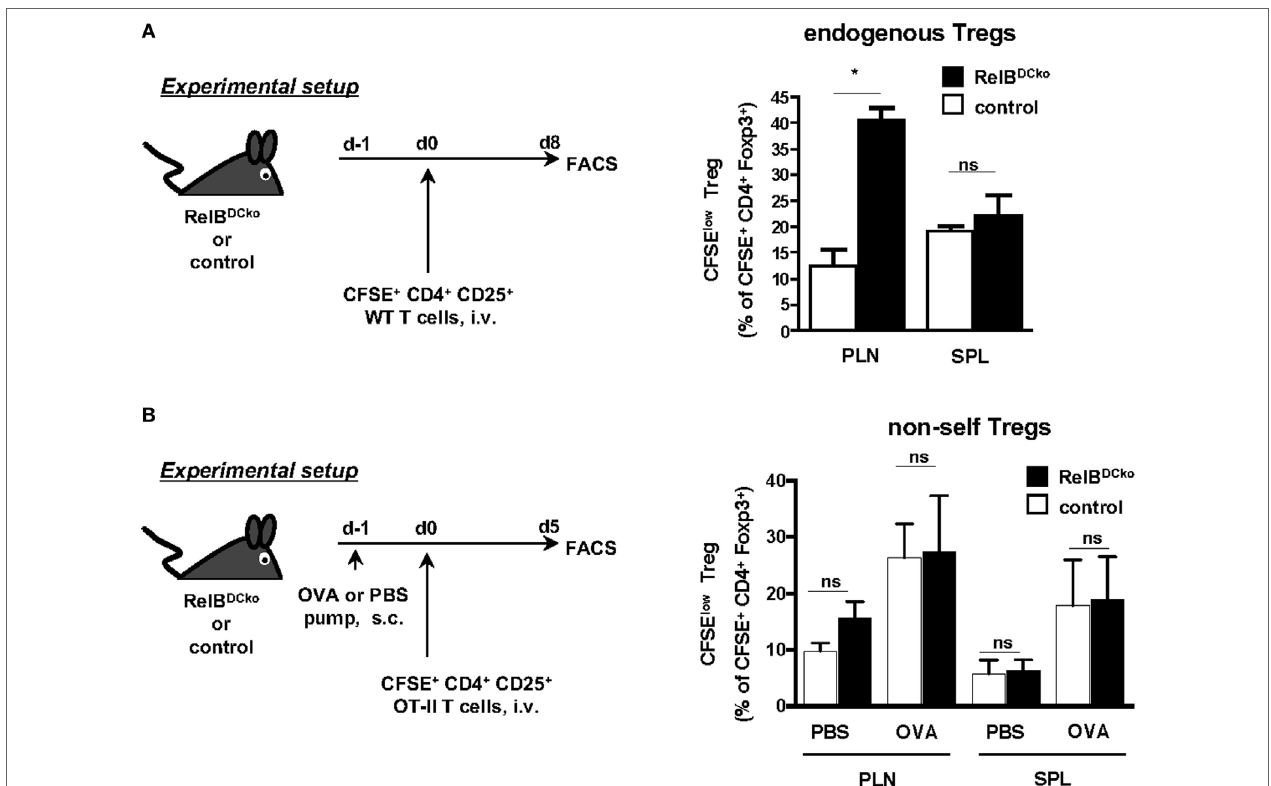
FigUre 4 | Expansion of self-antigen-specific Foxp3 + nTregs in peripheral lymph nodes of RelB DCko mice. (a) Carboxyfluorescein diacetate succinimidyl ester (CFSE)-labeled CD4 + CD25 + T cells (3 × 10 6 ) from wild-type mice were intravenously transferred into RelB DCko and control mice. Eight days later cell suspensions from peripheral LN and SPL were stained for CD4 and Foxp3 and analyzed by flow cytometry. Graphs display the percentages of proliferating (CFSE low ) cells among CFSE + CD4 + Foxp3 + T cells (right) as mean value + SD. Data shown are representative of two independent experiments with one mouse per genotype in each experiment. (B) PBS- or OVA peptide-loaded osmotic minipumps were subcutaneously implanted in RelB DCko and control mice. One day later mice received an intravenous injection of 1.4 × 10 6 CFSE-labeled CD4 + CD25 + OT-II T cells. For flow cytometric analysis, mice were sacrificed 5 days after adoptive transfer and stained for CD4 and Foxp3. Graphs display the percentages of proliferating CFSE low cells among all transferred CFSE + CD4 + Foxp3 + nTregs. Data represent the mean values + SD from one representative experiment with n = 2–5 mice per genotype and condition. (a,B) Statistical analyses were performed using unpaired student’s t -test: ns, not significant, * p <